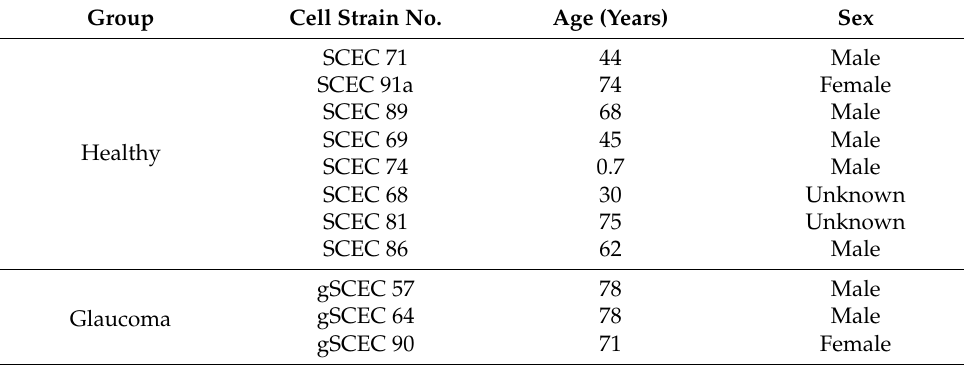
Table 2. Donor information for both healthy and glaucomatous SCEC strains. Group Cell Strain No. Age (Years)